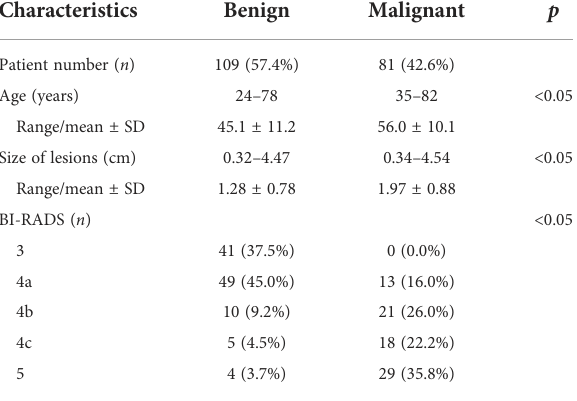
TABLE 1 Characteristics of patients and